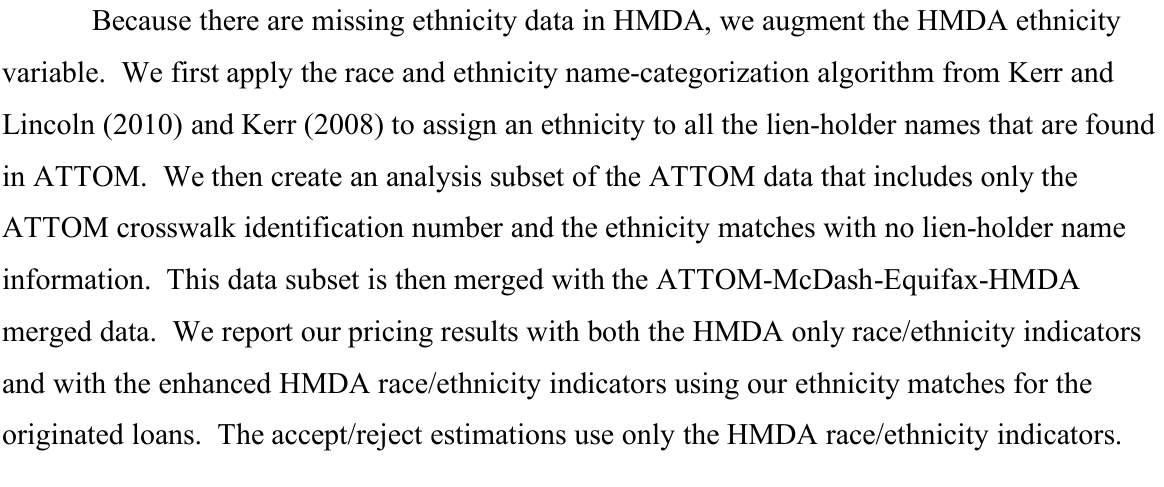
algorithm, obtaining a final data set of 6.8 million single-family, fixed-rate GSE loans originated between 2009 and